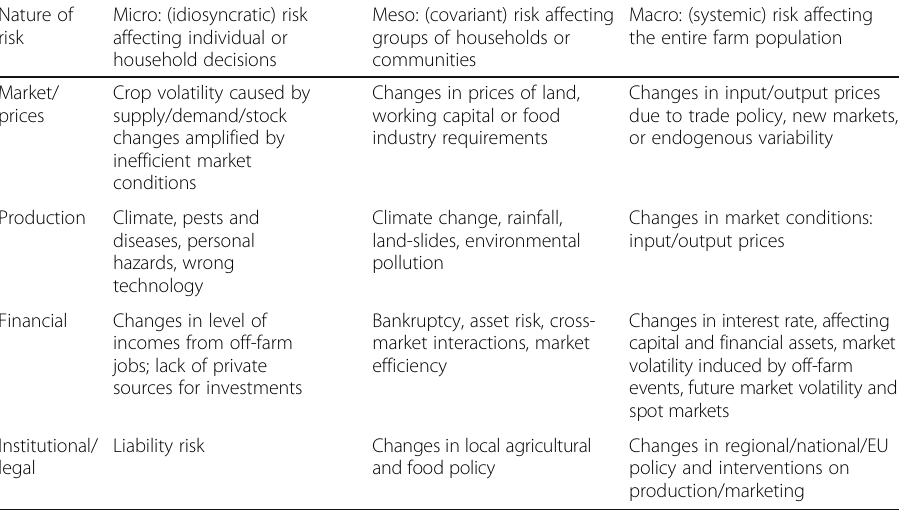
Meso: (covariant) risk affecting groups of households or communities Changes in prices of land, working capital or food industry requirements